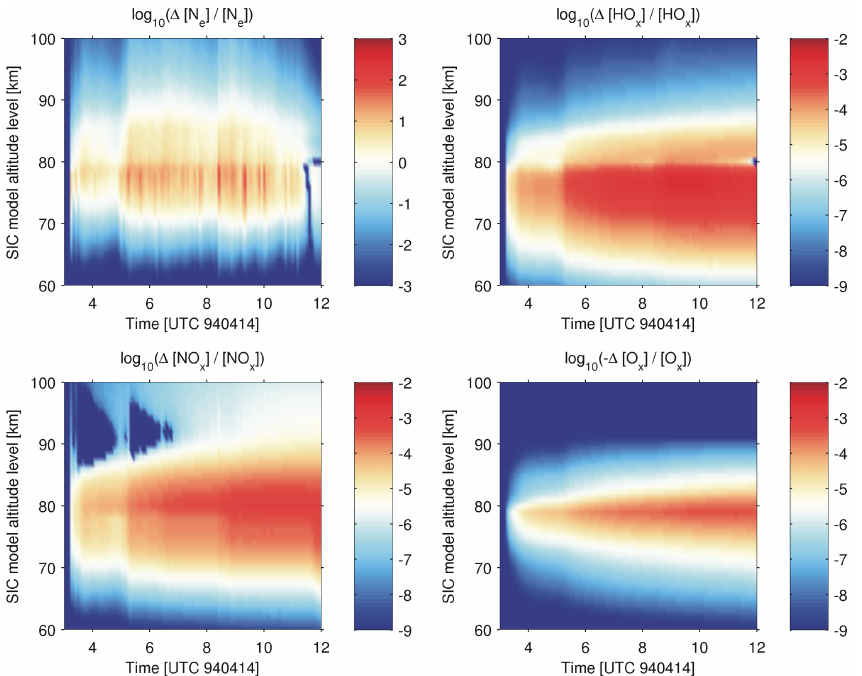
Fig. 7. Effect of the repeated and relatively intense WEP activity shown in Fig. 6, simulated by the SIC atmospheric chemistry model. The panels show the relative change in electron number density, NO x , HO x , and O x